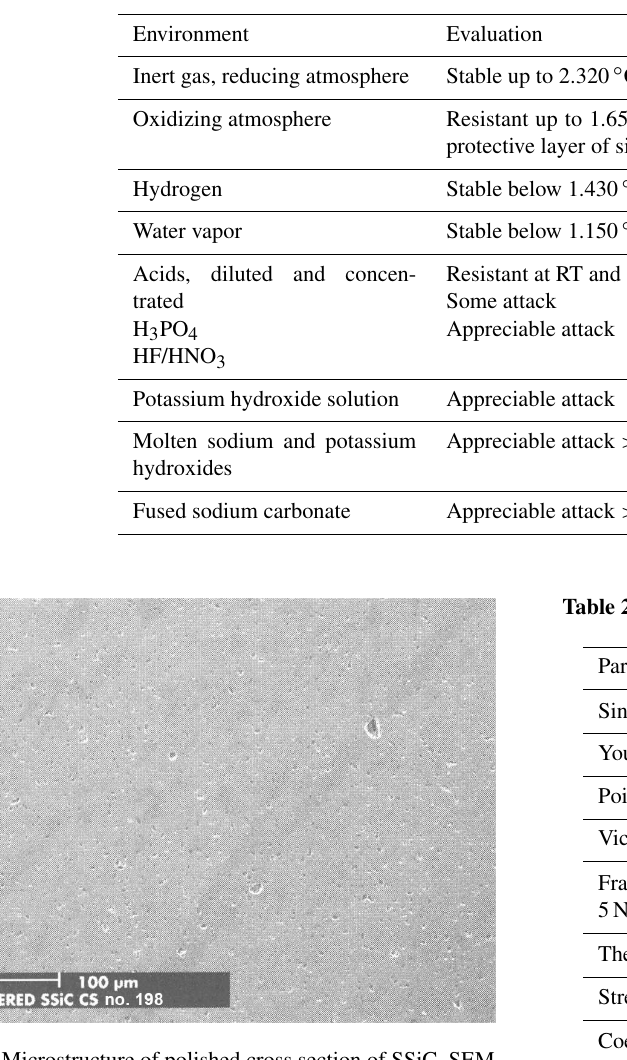
Table 1. Corrosion resistance of SSiC (Lay, 1983).